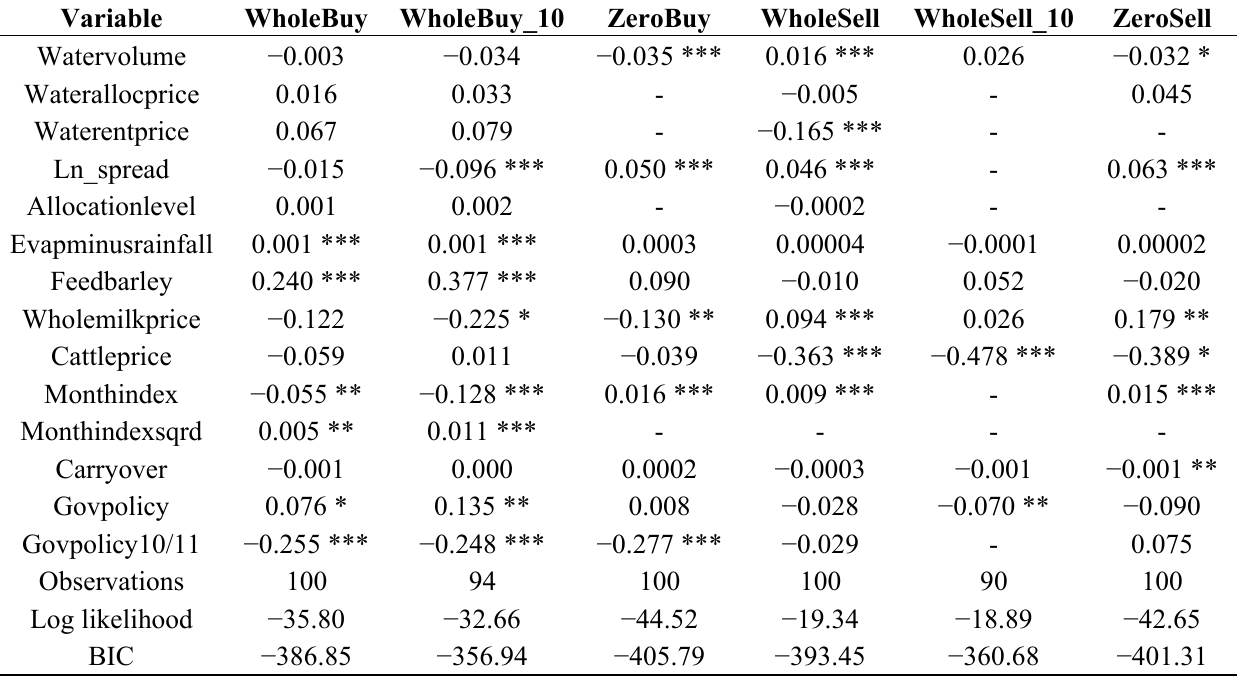
Table 5. Buy and sell offer monthly water allocation price